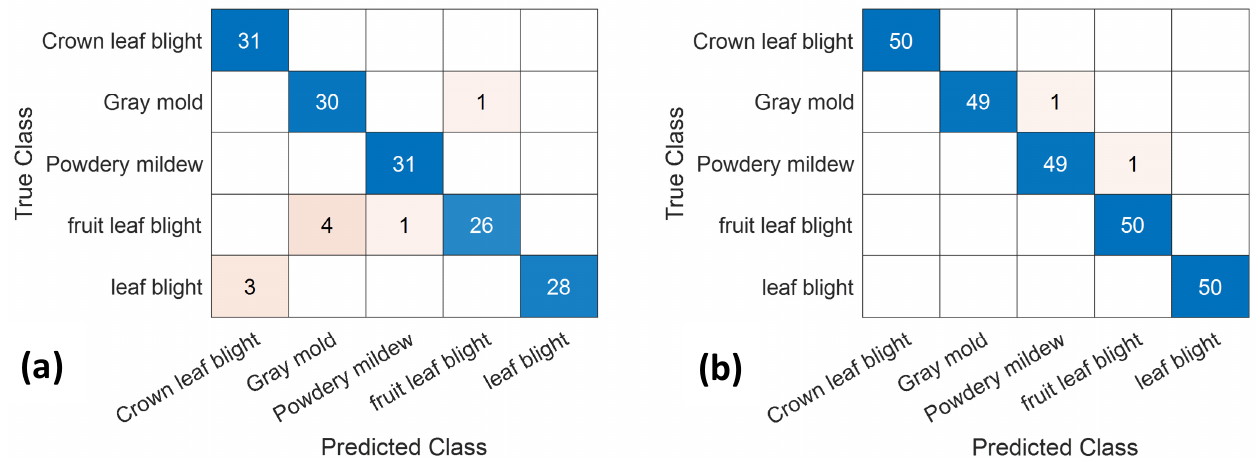
Figure 3. Confusion matrix with the Resnet50 model of 20 epochs of the ( a ) original dataset, and ( b ) feature